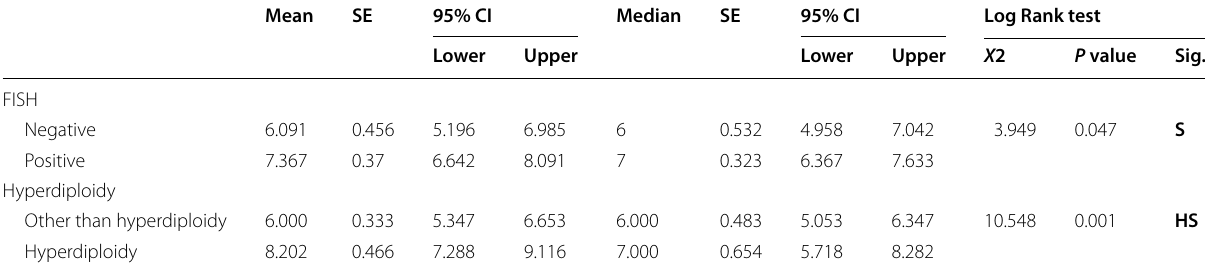
Table 5 Kaplan–Meier analysis for the relation between FISH results and hyperdiploidy with event free survival among the studied patients